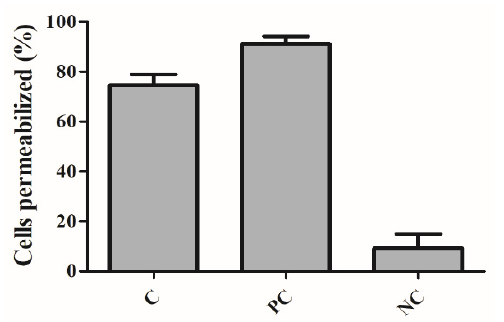
Figure 3. Percentage of disrupted Bacillus subtilis cells. C: cells treated with IBC ; PC: cells treated with nisin (positive control) and NC: cells treated with 1% DMSO (negative control).